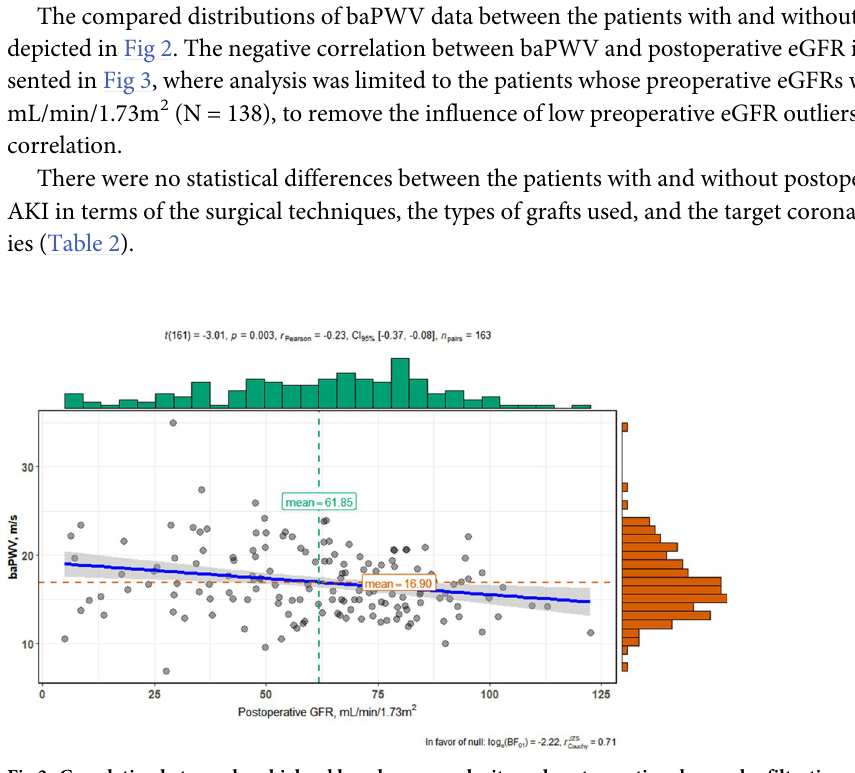
Fig 3. Correlation between brachial-ankle pulse wave velocity and postoperative glomerular filtration rate. Subjects were limited to patients with preoperative eGFR � 50 mL/min/1.73m 2 (n = 138). γ = Pearson’s coefficient of correlation. baPWV, brachial-ankle pulse wave velocity; CI, confidence interval; GFR, glomerular filtration